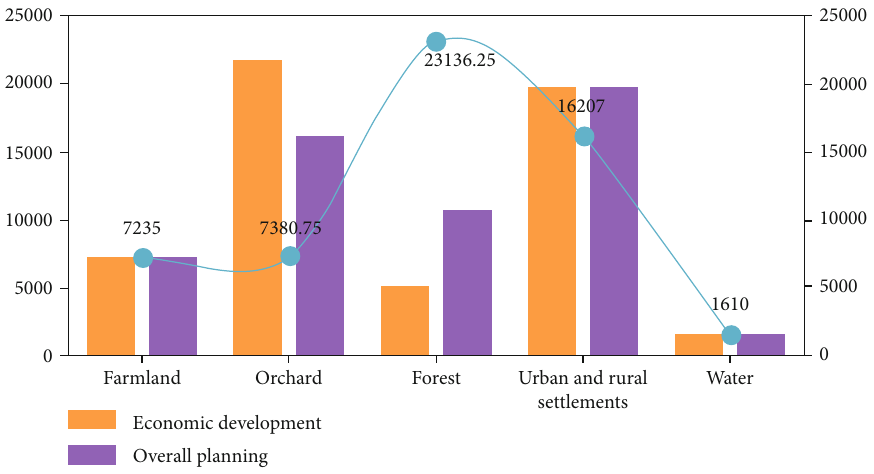
Figure 5: Results of landscape area optimization for each scenario in 2024.